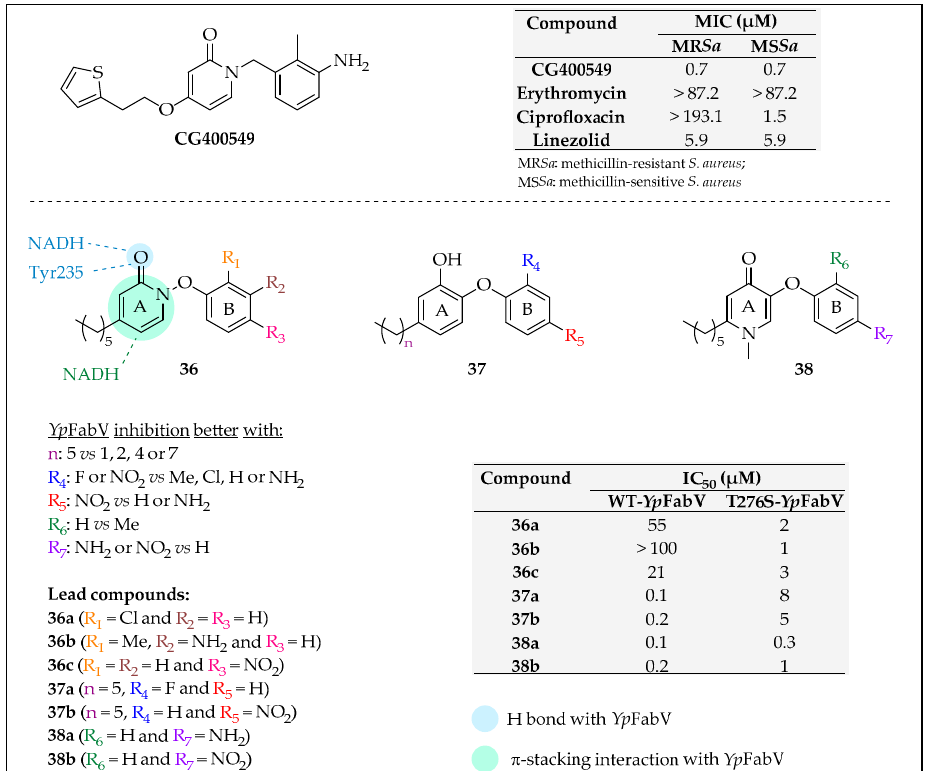
Figure 33. Structure, SAR and representation of main interactions with Yp FabV of CG400549 and 36-38 and in vitro activities of lead compounds [17,157].